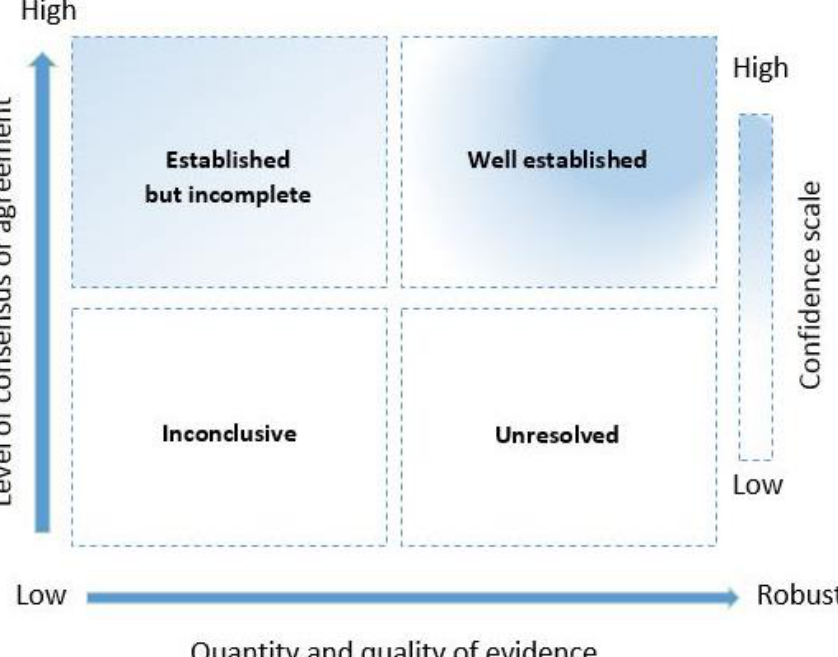
Figure 1. Confidence rises toward the top-right corner, as suggested by the growing strength of shading.